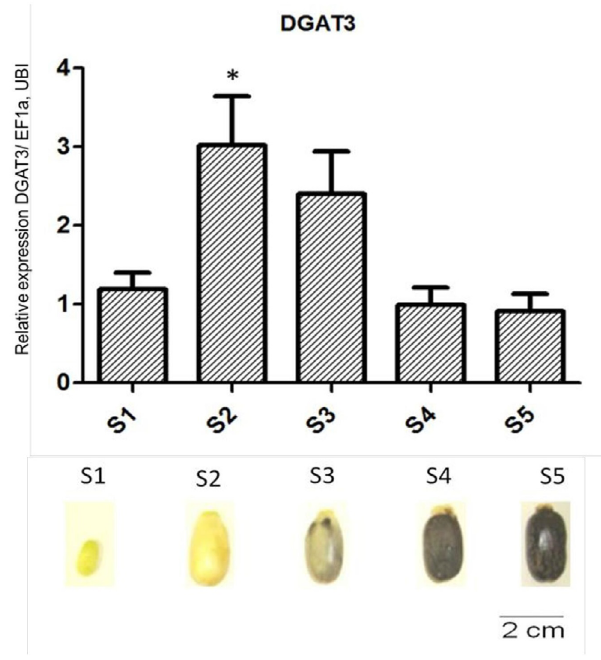
Figure 1 – RcDGAT3 mRNA expression profile in castor been ( Ricinus communis L.) developing seeds. Relative RT-qPCR expression using stage S1 as reference and RcUBI and RcEF1a as reference genes. Developing seed stages (S1 – S5) were described in (Cagliari et al. , 2010). Bars represent standard error, and the asterisk indicates P < 0.05 by ANOVA